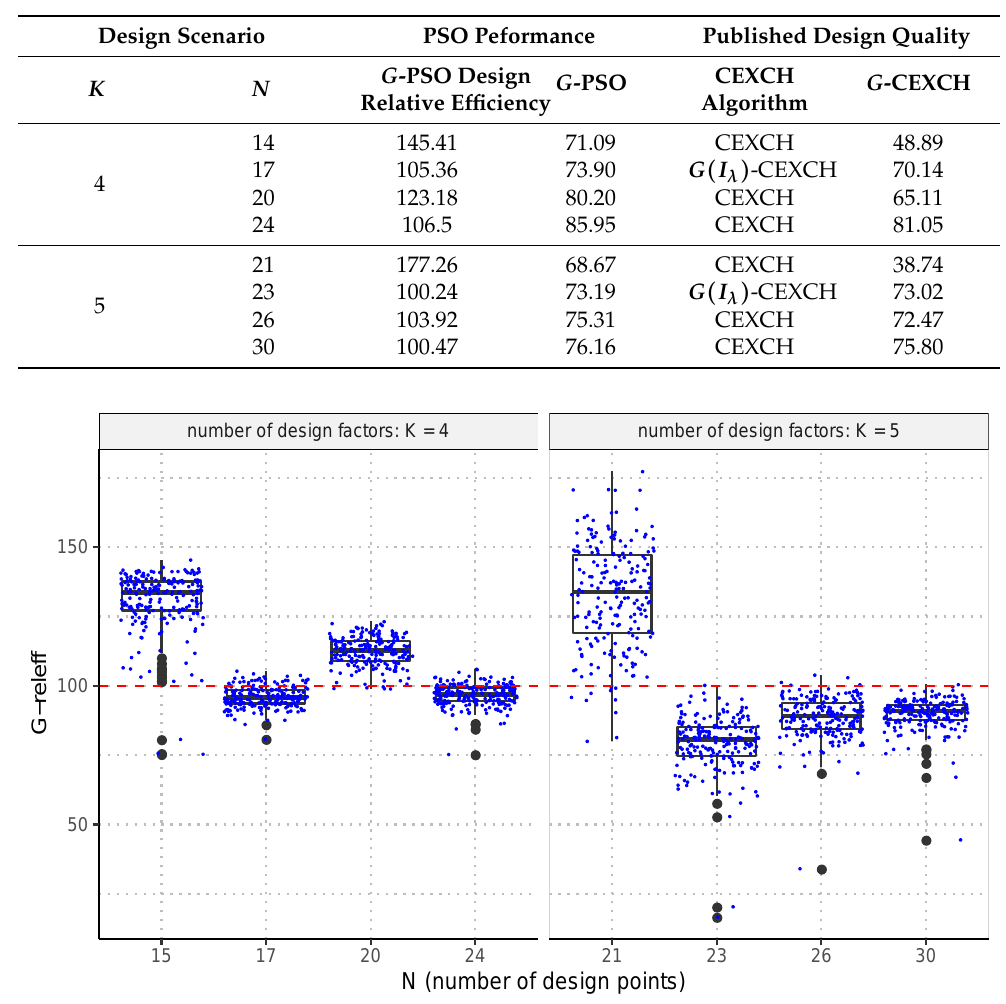
Figure 2. Distributions of G -PSO design efficiencies relative to the published CEXCH designs for K = 4,5